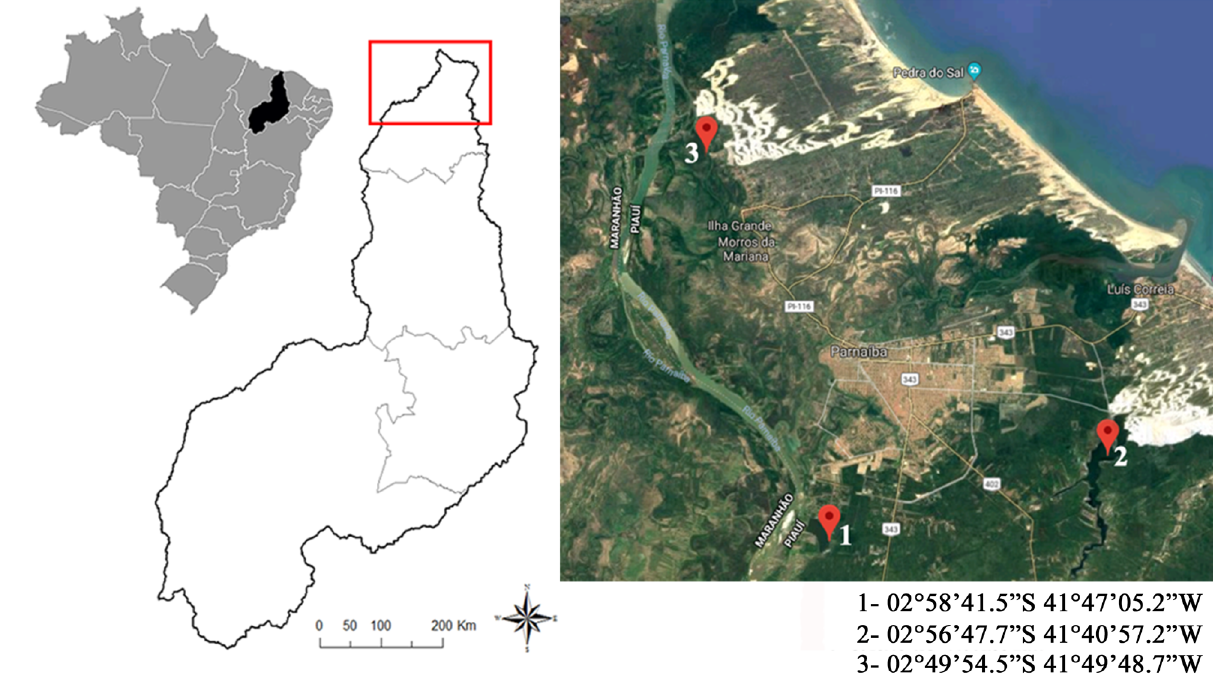
Figure 1. Map of Brazil indicating the state of Piauí and the Parnaíba River delta region. Sampling points marked in red dots: 1- Prata Lagoon; 2- Portinho Lagoon; 3- Parnaíba